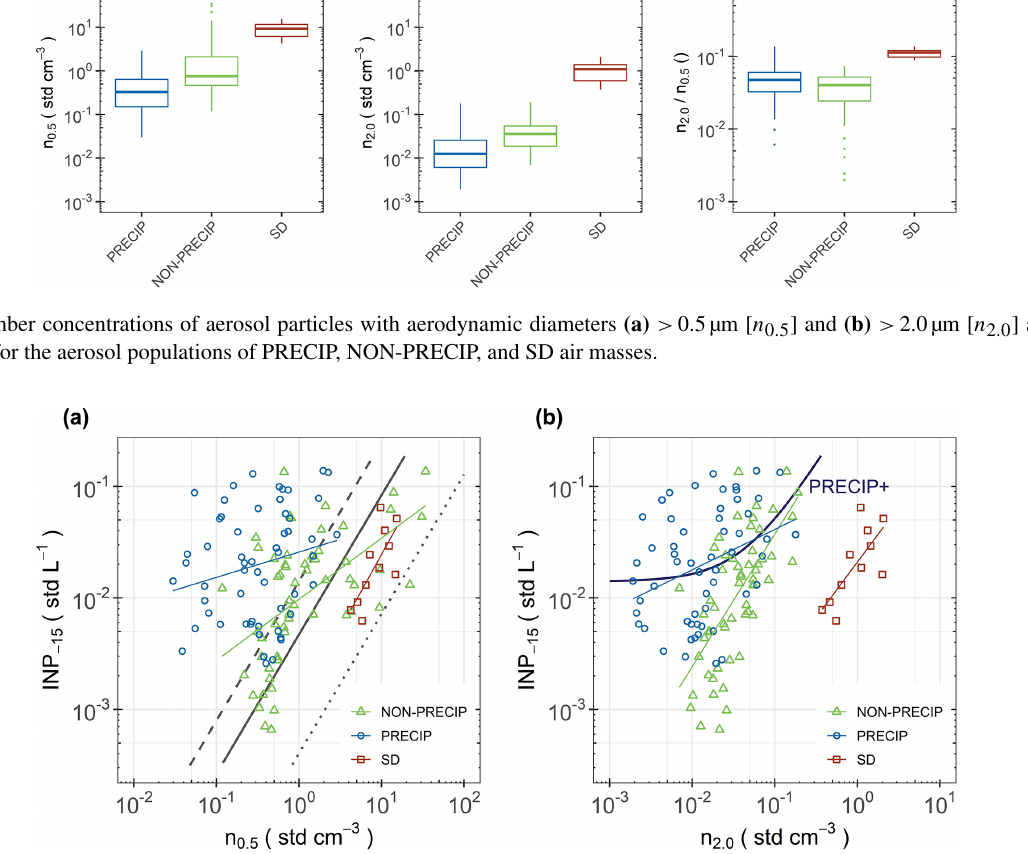
Figure 3. Cumulative concentrations of ice-nucleating particles active at − 15 ◦ C [INP − 15 ] (a) versus [ n 0 . 5 ] and (b) versus [ n 2 . 0 ] for PRECIP (blue circles), NON-PRECIP (green triangles), and SD (red squares) air masses. Power functions (solid lines) for each type of air mass based on [ n 0 . 5 ] and [ n 2 . 0 ] are shown. An additional preliminary parameterisation for precipitating air masses based on [ n 2 . 0 ] is shown (PRECIP+, thick dark blue line). It is the same as for non-precipitating air masses but with an added constant equivalent to 0.014INPsL − 1 . The corresponding equations and R 2 values are shown in Table 1. The grey lines show the D15 parameterisation extrapolated to − 15 ◦ C and corrected for the difference between physical and aerodynamic diameters (see the “Material and method” section) with three different calibration factors (Eq. 1): CF = 3 (dashed), CF = 1 (continuous), and CF = 0.086 (dotted). The latter value was the best fit found by Schrod et al. (2017) for Saharan dust above